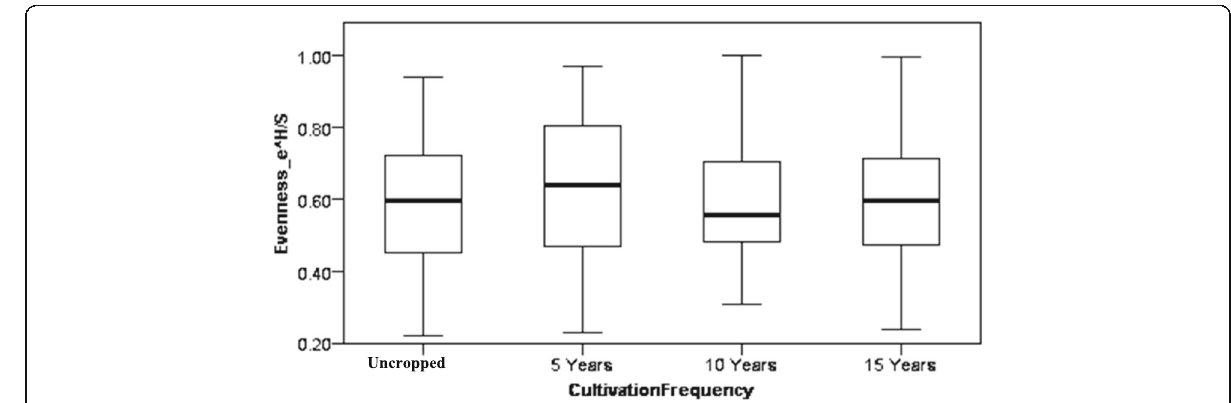
Fig. 8 Graphical representation of the independent-samples Kruskal – Wallis test on species evenness across the study